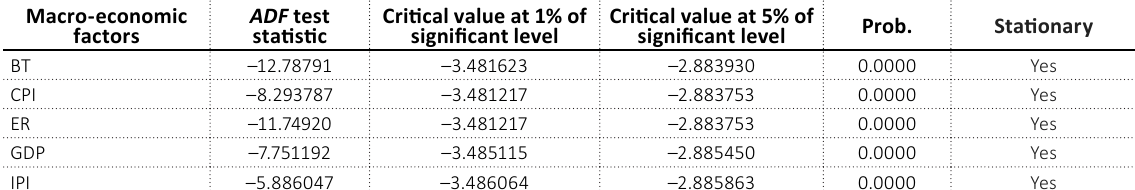
Table 5. Unit root tests results for Jordanian market